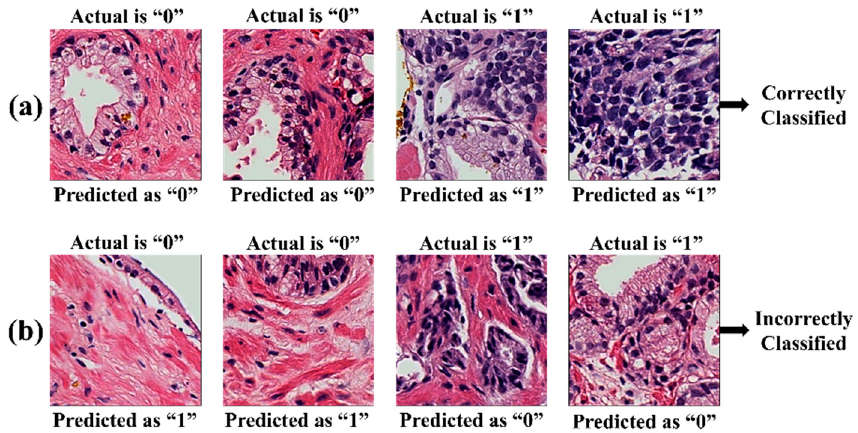
Figure 12. Cancer prediction using a binary labeled test dataset. Examples of images that were ( a ) correctly and ( b ) incorrectly classified, showing their actual and predicted labels.